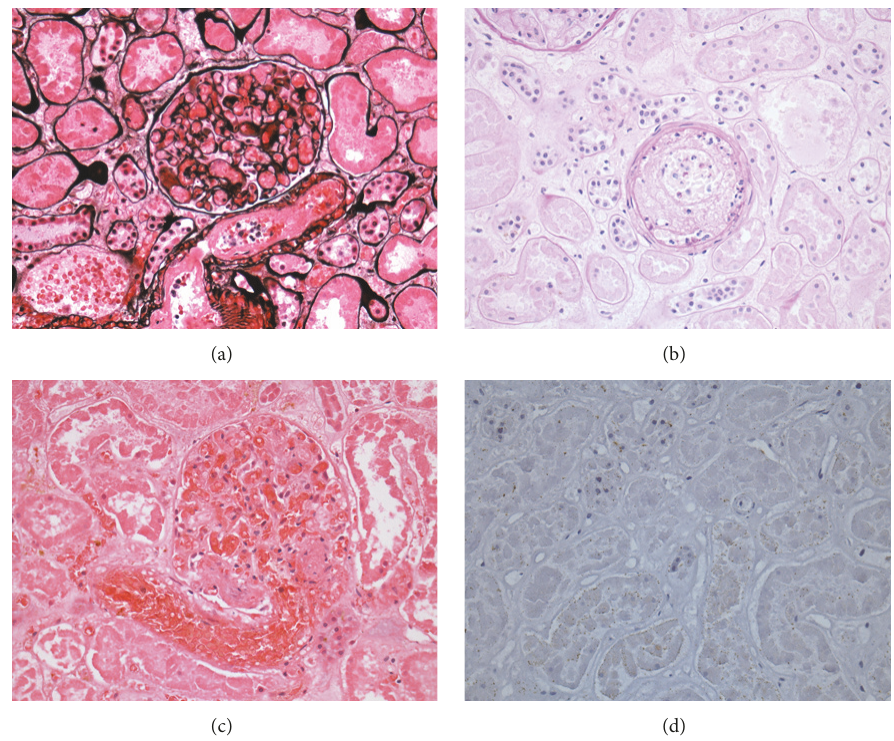
Figure 3: Micrographs of graft nephrectomy (40x) . Stained, respectively, with Jones’ Methenamine (a), PAS (b), Hematoxylin and Eosin (c), and indirect peroxidase immunostaining for C4d (d). In all sections, fibrin thrombi adhered to the endothelium of the glomeruli ((a) and (c)) and the arteriolar walls (b) can be observed. C4d (d) was negative. All photomicrographs are in